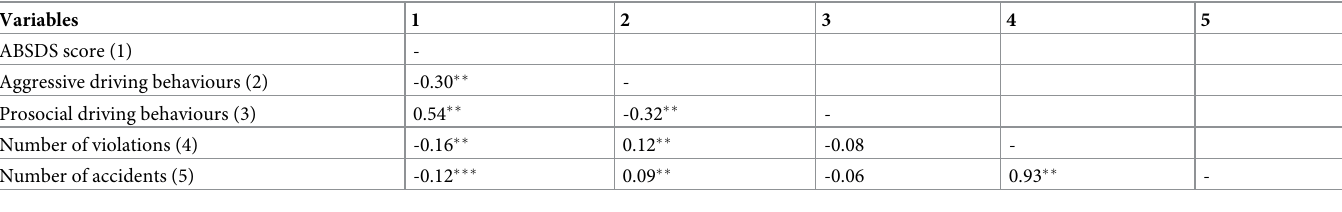
Table 4. Correlations between the ABSDS, PADI factors and traffic